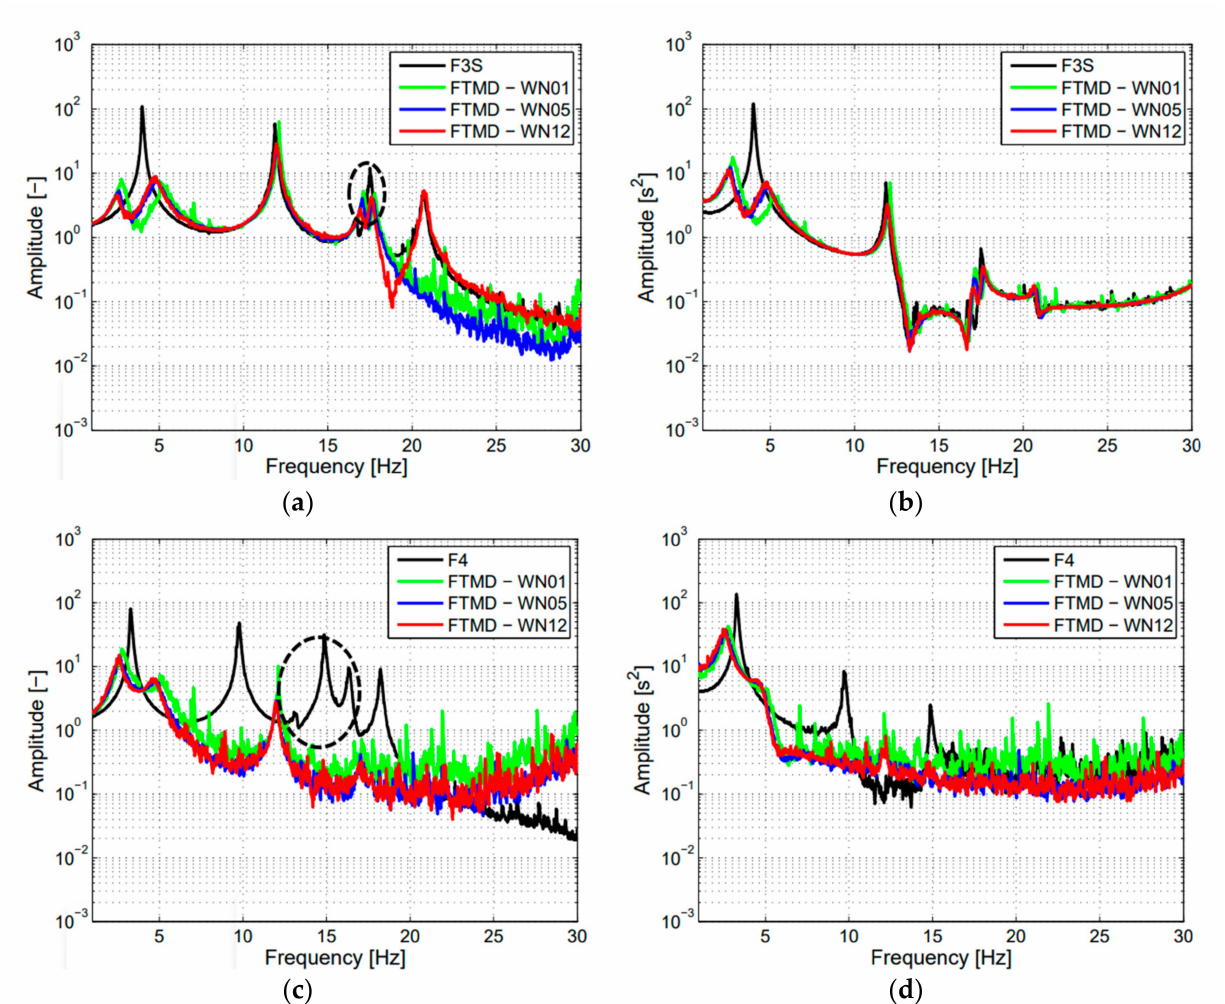
Figure 8. WN. Frequency response functions: ( a ) absolute acceleration at support plane, ( b ) relative displacement at support plane, ( c ) 4th floor absolute acceleration, ( d ) 4th floor rela- tive displacement. Legend: F3S, F4, FTMD configurations at RMS amplitudes WN01 = 0.002 g, WN05 = 0.008 g, WN12 = 0.025 g. Circles in the figure indicate additional modes due to asymmetric base boundary